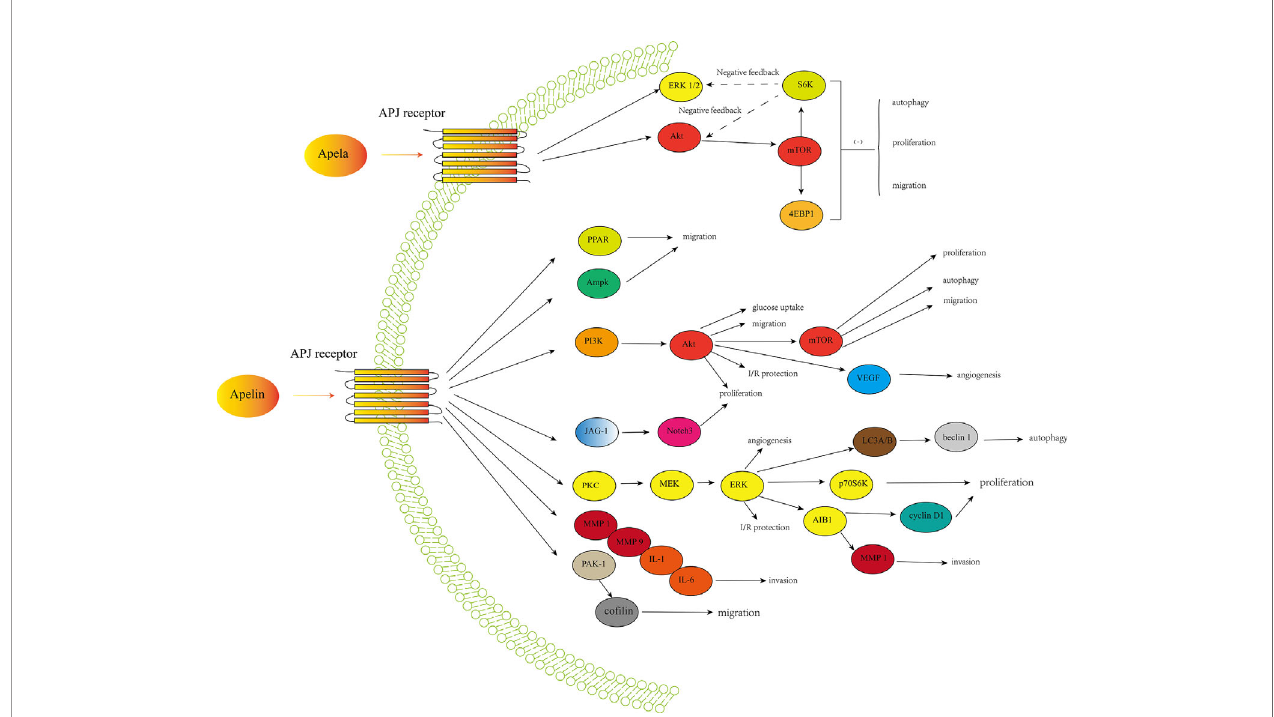
FIGURE 1 | A simple overview of the apelin/APJ-induced signaling pathways and Apela/APJ-induced signaling pathways involved in cancer development and